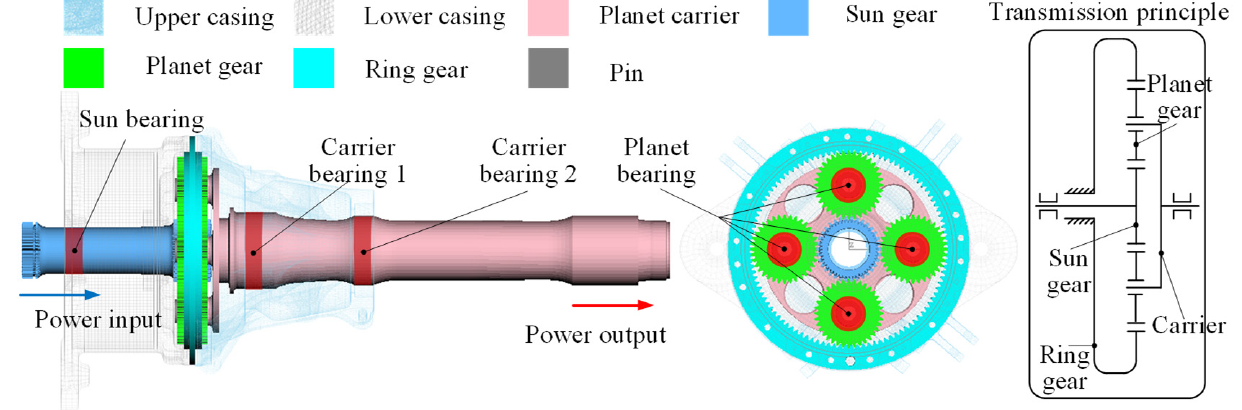
Figure 2. The PGT system. The coordinate system settings are shown in Figure 3. The degrees of freedom (DOF) of the sun gear, ring gear and translational DOF of the planet carrier are defined in the moving coordinate system o c ‑ x c y c z c rotating with the planet carrier. The DOF of the planet gears and pins are defined in the coordinate system o p ‑ ξη z p ; the torsional DOF θ c of the planet carrier and DOF of the casing are defined in the coordinate system o 0 ‑ x 0 y 0 z 0 . Set the coordinate system o 1 ‑ x 1 y 1 z 1 to describe the aircraft’s rotation around itself, and set the Earth coordinate system O ‑ XYZ to describe the complex attitude of the airframe in space. Among them, the axes of the coordinate system o 1 ‑ x 1 y 1 z 1 are, respectively, parallel to the axes of the coordinate system o 0 ‑ x 0 y 0 z 0 , where o 1 is the center of gravity of the aircraft, and the flight direction of the aircraft is the same as the o 1 y 1 axis (aircraft symmetry